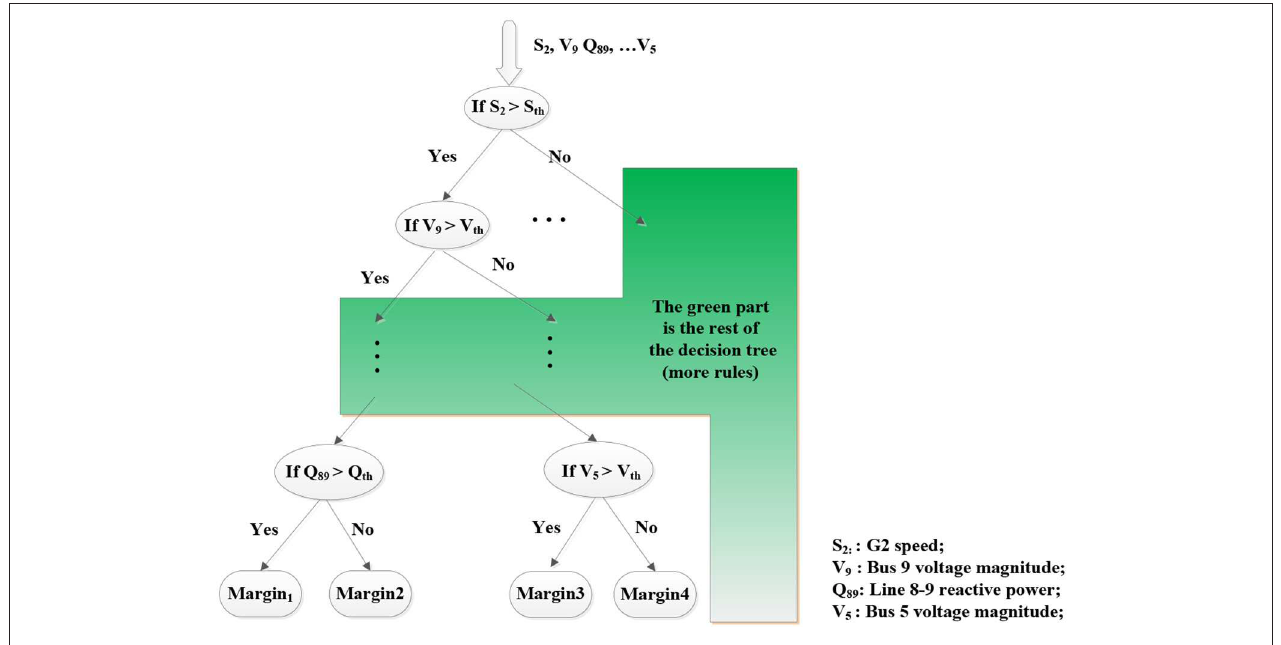
FIGURE 7 | Illustration of decision